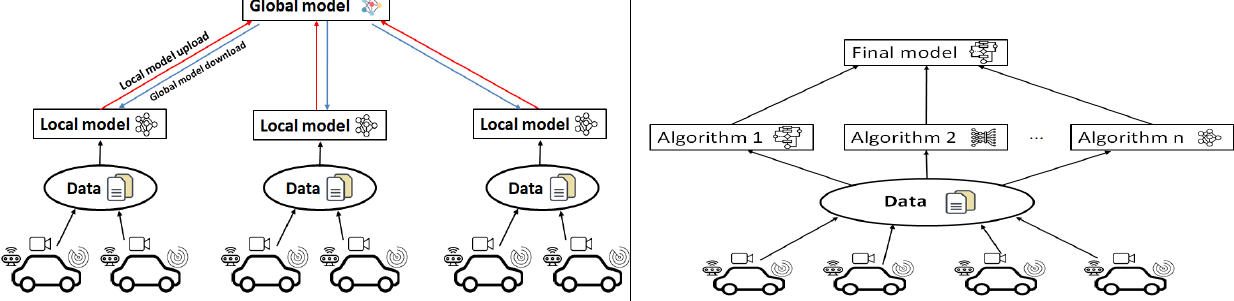
Figure 6. Learning parallelism (left: data parallelism, the same model; right: model parallelism, different